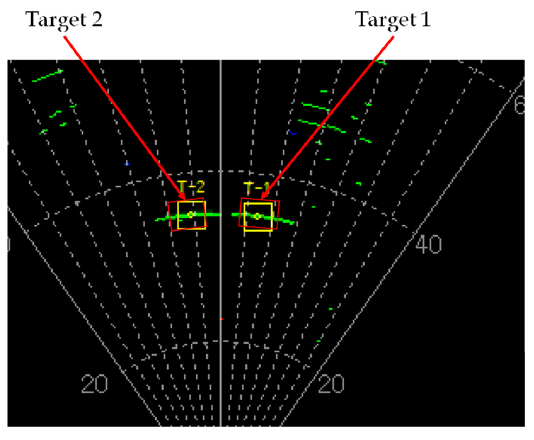
Figure 24. PPI display showing the angular resolution. Finally, Figure 25 shows the PPI display for two corner reflectors spaced 30 m apart, indicating the angular coverage.